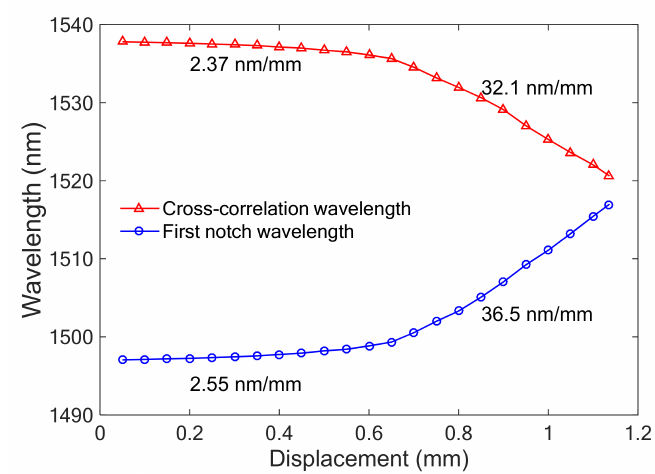
Figure 7. The displacement sensing curve of the notch wavelength shifting (blue line) and cross-correlation peak shifting (red